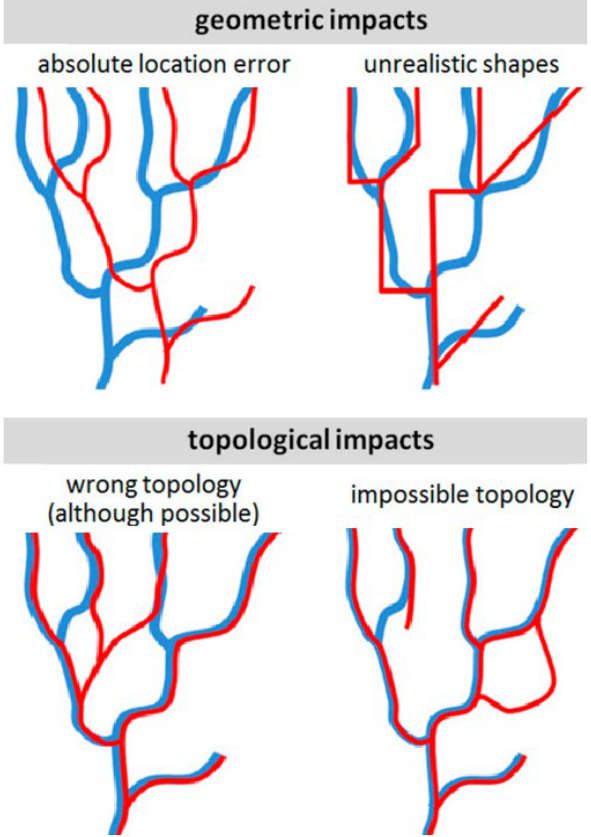
Figure 2. Effects of main DTM error behaviours on extracted drainage errors, with ground truth in blue and extracted network in red (adapted from Polidori and El Hage,